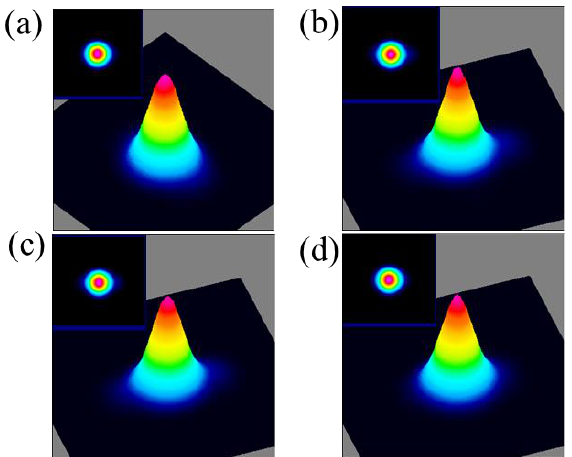
Figure 9. The 2D and 3D spatial power distribution of CW ( a ) and PQS Nd:YAG laser at the pump power of 3 W ( b ), 3.5 W ( c ), and 4.5 W ( d ). The output properties of Q-switched solid-state lasers modulated by different 2D Materials-SAs are shown in Table 1. The Nd:YAG/Ti 2 CT x -SAs laser has a shorter pulse duration than the most 2D Materials-SAs based lasers. Compared to other MXene-SAs based lasers, the average output power, output pulse energy, and pulse peak power of the Nd:YAG/Ti 2 CT x -SAs laser are much higher. Besides, compared to the Nd:YAG/Ti 3 C 2 T x - SAs laser, the average output power, output pulse energy, and pulse peak power are in- creased by about 10 times, 6 times, and 11 times. The optical conversion efficiency of this Nd:YAG/Ti 2 CT x -SAs laser also stands out from the list. The specially designed laser reso- nator (relatively short cavity, optimal OC) also contributed to the good output character- istics [45,46]. Some MXene/polymers SAs have been successfully used in ultrafast lasers [47–49]; by combining MXene with the polymers, the properties of the MXene-SAs have been improved. Further work could be done to improve the properties of the MXene Ti 2 CT x -SAs in Q-switched solid-state lasers. Table 1. Comparison of different 2D materials-SAs used in Q-switched solid-state lasers. SAs